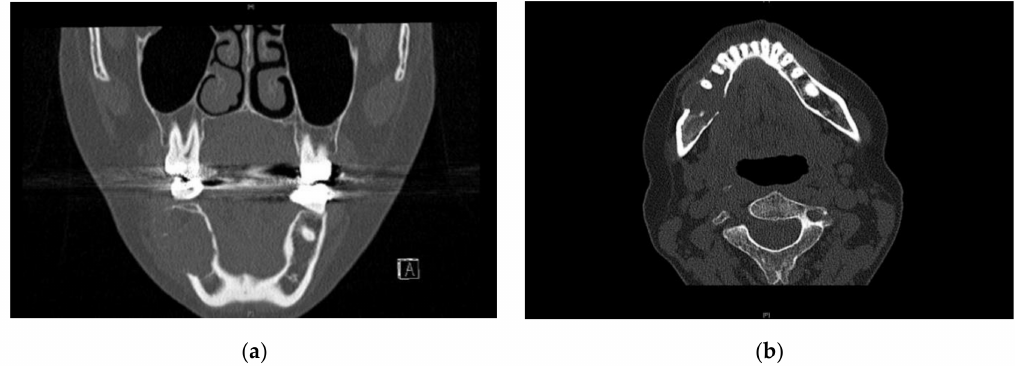
Figure 3. CT scans showing expanded cortical bone on the right side of the mandible. ( a ) coronal plane, ( b ) axial